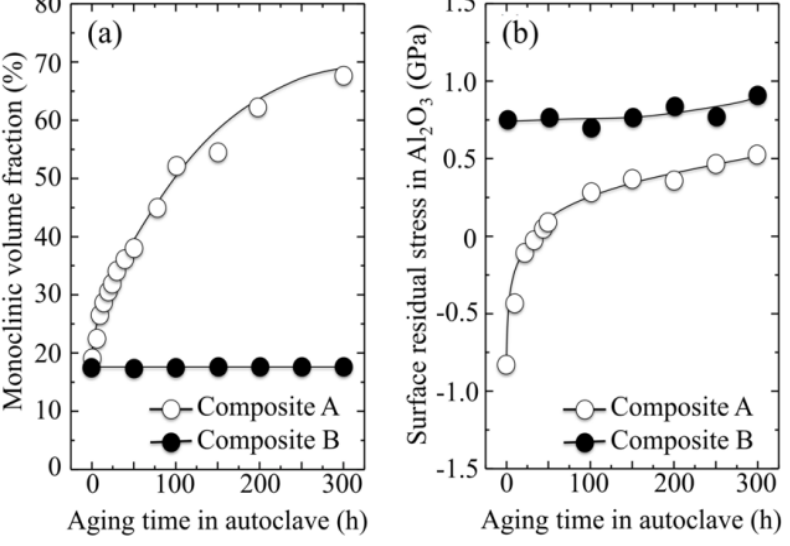
Figure 12. ( a ) Volume fractional evolution of the ZrO microstructure of Composites A and B as a function of aging time in a climate test chamber (the y -axis refers to fractions of the overall ZrO stress stored onto the surface of the Al function of aging time in a climate test